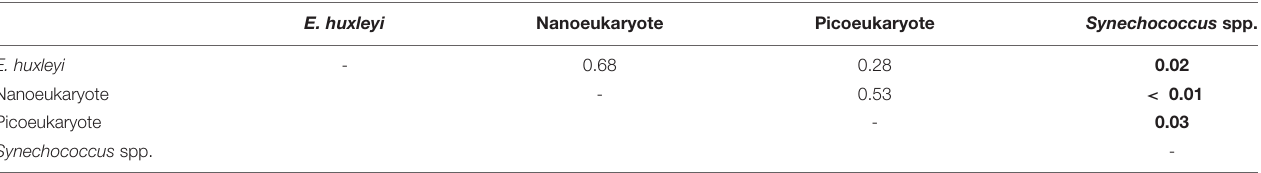
FIGURE 2 | Box plots of arctangent grazing: growth ratios (g: µ ) of different phytoplankton groups. Unfilled points represent outliers of the data set but are still included in data analysis. Dashed lines labeled as 1.0 and 0.5 represent 100 and 50% of daily growth consumed by grazers, respectively, of tangent ( × ) values. Bold italicized values are the median values converted back from arctangent values using the tangent ( × ) function. Red points are from non-mesocosm field experiments from Mayers et al. (2018) in the Celtic Sea (Northwest European Shelf). TABLE 2 | p- values from a two-sided Kolmogorov-Smirnov test of g: µ ratios between different phytoplankton